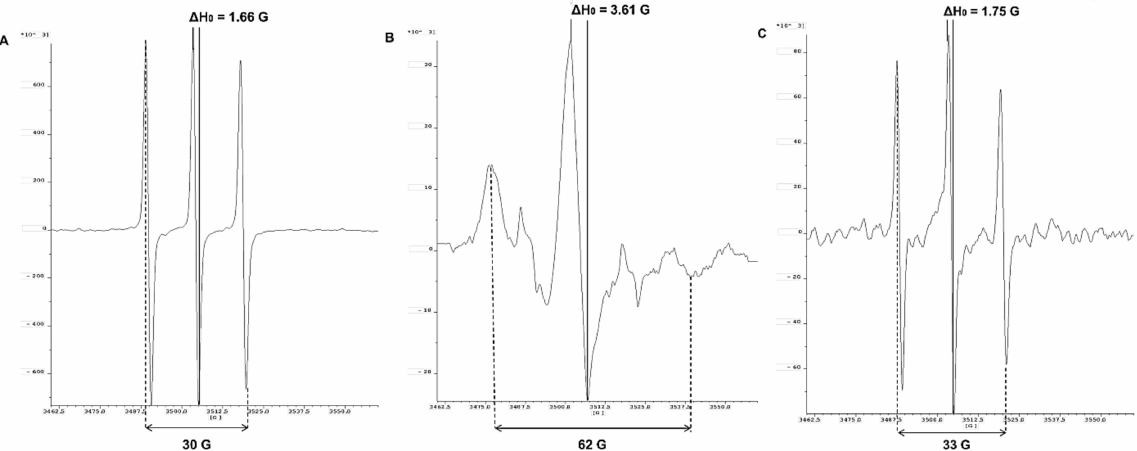
Figure 1. 3-Maleimido-PROXYL radical spectra: Control of 3-Maleimido-PROXYL/DMSO without serum ( A ); in serum samples of healthy patients ( B ); in serum samples in patients with COVID-19 ( C ).